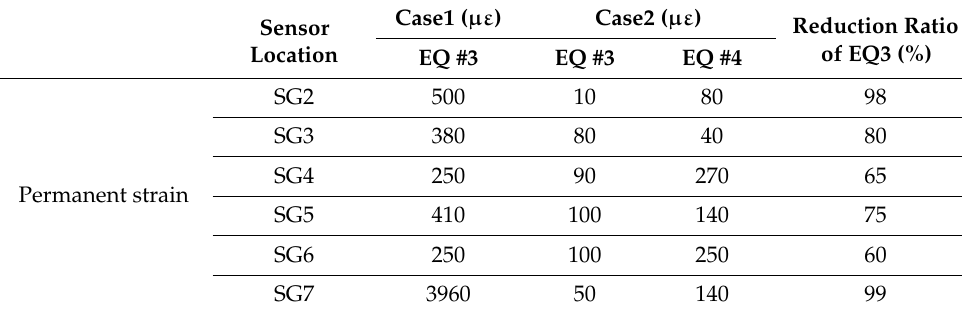
Figure 9. Failure of the RTU system due to EQ #4 (test 8) for Case 2. Table 9. Permanent strain